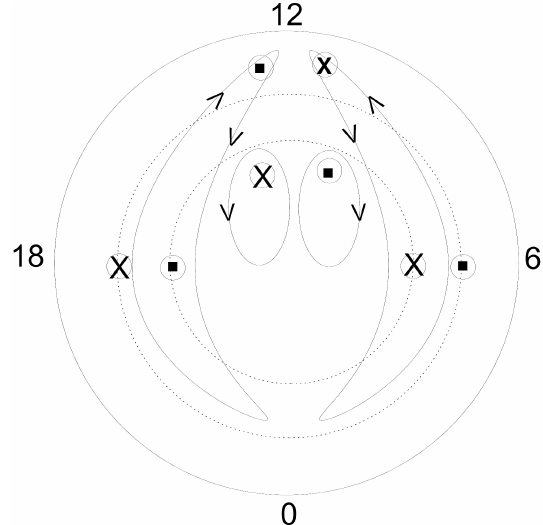
Fig. 6. Field-aligned currents and convection in the polar cap for northward IMF. From high to lower latitudes: NBZ currents, Region I and II currents, currents near the cusp region on the closed field lines (Clauer et al.,